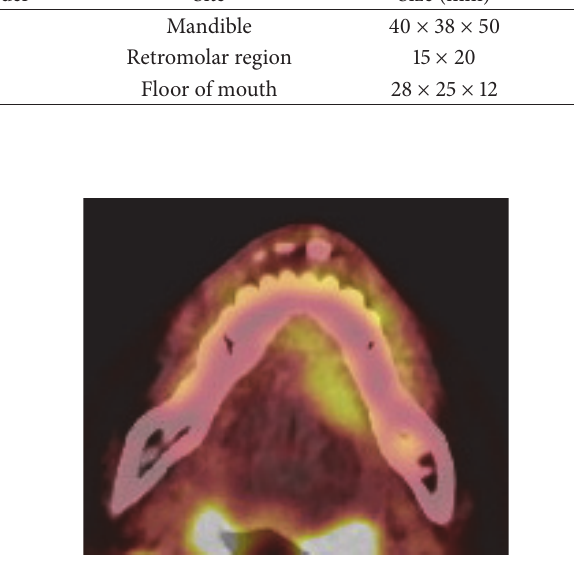
Figure 3: FDG-PET. The sublingual mass measured 28 × 13mm and had a max SUV of 10.4.